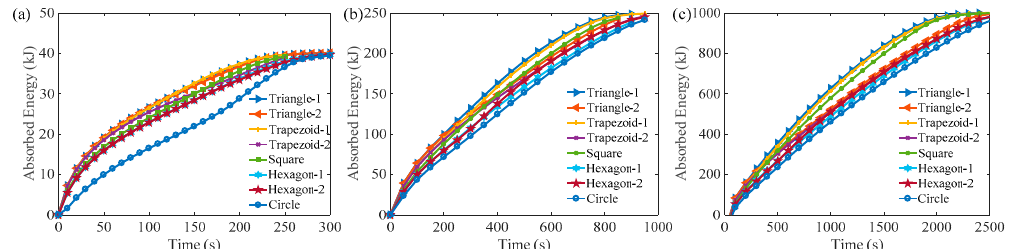
Figure A2. Temporal evolutions of the profiles of energy absorption in the triangular, trapezoidal, square, hexagonal, and circular cells ( AR = 1.0) at ( a ) Ra = 3.095 × 10 5 ; ( b ) Ra = 4.83 × 10 6 ; ( c ) Ra = 3.87 × 10 7 .